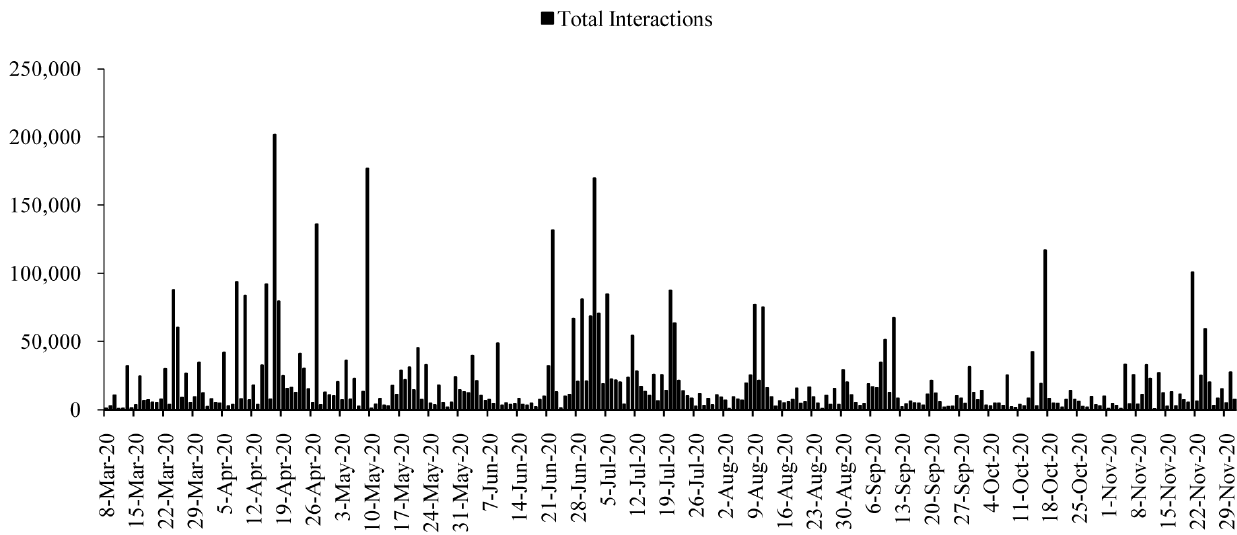
Figure 2. Interaction distributions during the